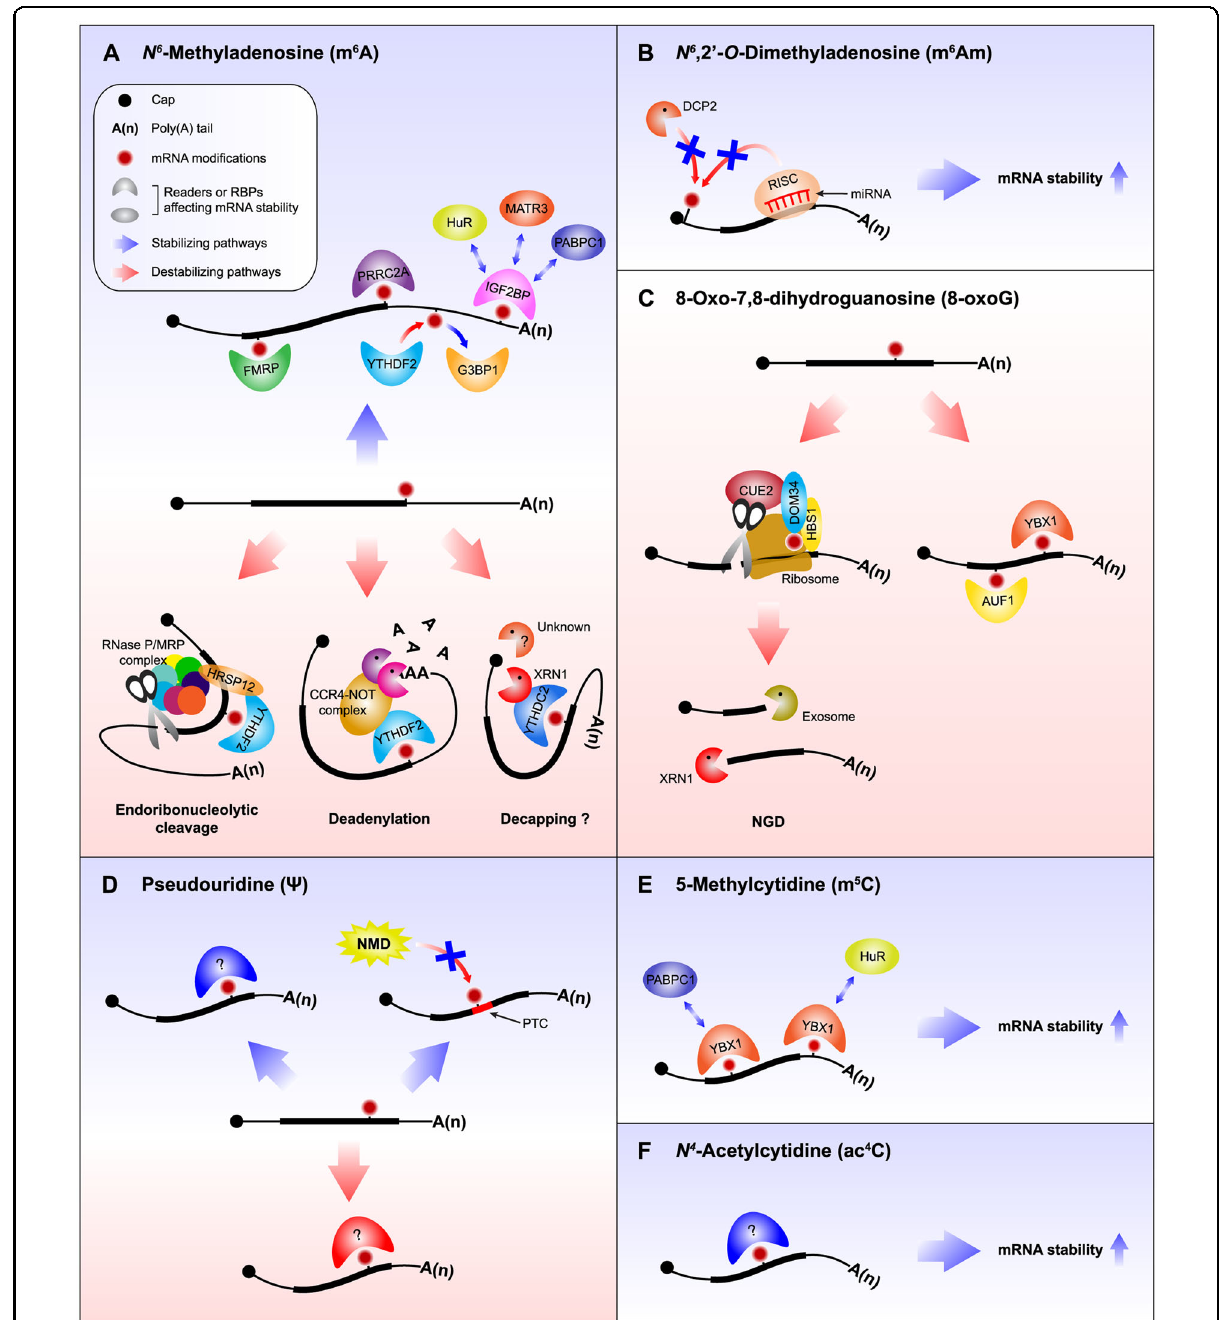
Fig. 2 Molecular mechanisms underlying the regulation of mRNA stability through diverse RNA modi fi cations. a N 6 -methyladenosine (m 6 A): in general, YTH domain-containing proteins destabilize m 6 A-containing mRNAs. When m 6 A is recognized by YTHDF2, the degradation of m 6 A- containing mRNAs is initiated by deadenylation through the CCR4 – NOT complex. If the YTHDF2-bound m 6 A-containing mRNA harbors an HRSP12- binding site, the degradation of the mRNA is preferentially initiated through an endoribonucleolytic cleavage reaction mediated by the RNase P/MRP complex. YTHDC2 binds to m 6 A and recruits XRN1, thereby triggering 5 ′ – 3 ′ exoribonucleolytic cleavage. In contrast, m 6 A-containing mRNA can be stabilized by other m 6 A reader proteins or RBPs, including IGF2BP, FMRP, G3BP1, PRRC2A, and HuR. b N 6 ,2 ′ - O -dimethyladenosine (m 6 Am): the presence of m 6 Am at the 5 ′ -end of mRNA blocks its accessibility to DCP2, thus stabilizing the mRNA. m 6 Am also enables mRNA to become more resistant to microRNA-mediated mRNA degradation. c 8-Oxo-7,8-dihydroguanosine (8-oxoG): the presence of 8-oxoG in mRNA causes ribosome stalling, thereby triggering NGD. Alternatively, 8-oxoG-containing mRNAs are degraded through 8-oxoG reader proteins, such as YBX1 and AUF1. d Pseudouridine ( Ψ ): Ψ can stabilize or destabilize mRNA. In particular, Ψ on PTCs results in the inhibition of NMD. As a consequence, the mRNA is stabilized. e 5-Methylcytidine (m 5 C): YBX1 speci fi cally recognizes m 5 C on mRNA and recruits either PABPC1 or HuR, thereby stabilizing the